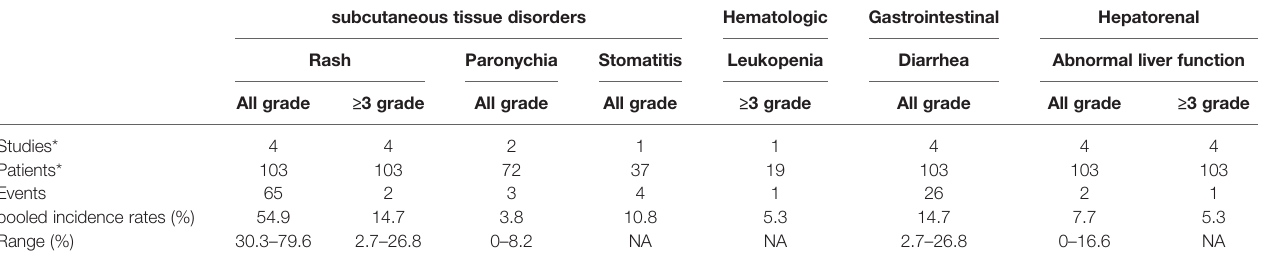
TABLE 3 | The main toxicity of neoadjuvant EGFR-TKI